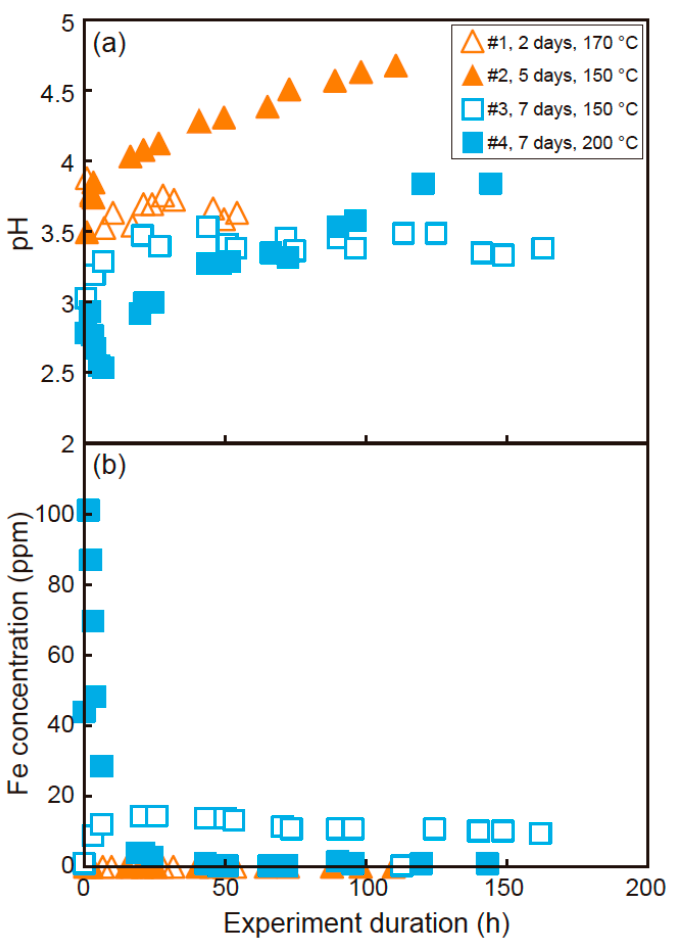
Figure 3. ( a ) pH and ( b ) Fe concentration for solution samples as a function of experiment duration in runs 1–4.